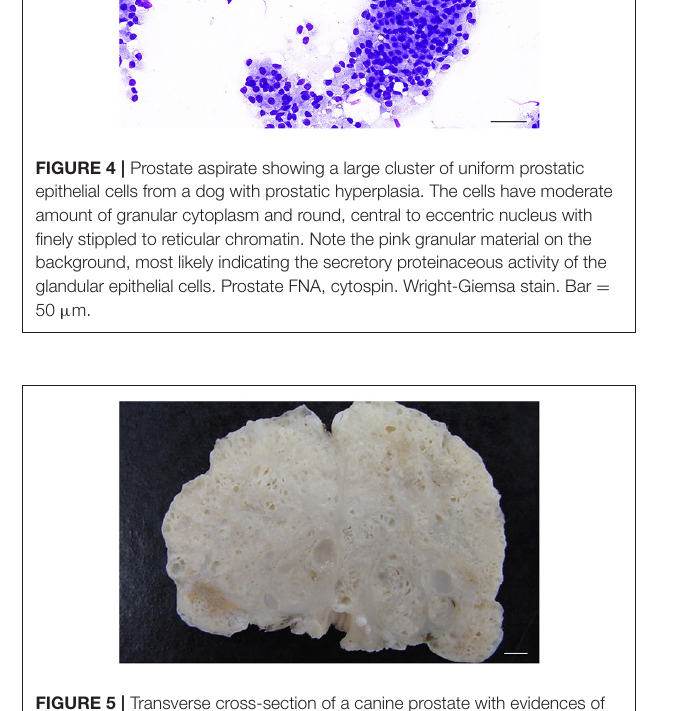
FIGURE 5 | Transverse cross-section of a canine prostate with evidences of prostatic hyperplasia. Enlarged prostate with multifocal small cystic lesions. Bar =